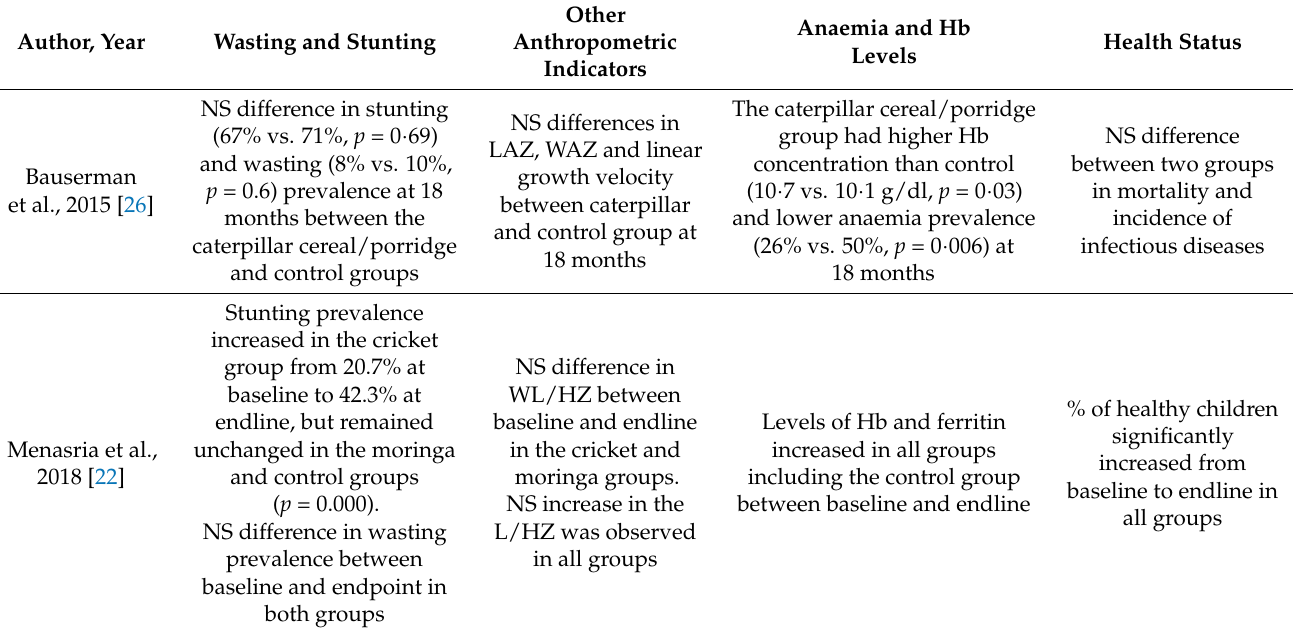
Table 5. Nutritional status